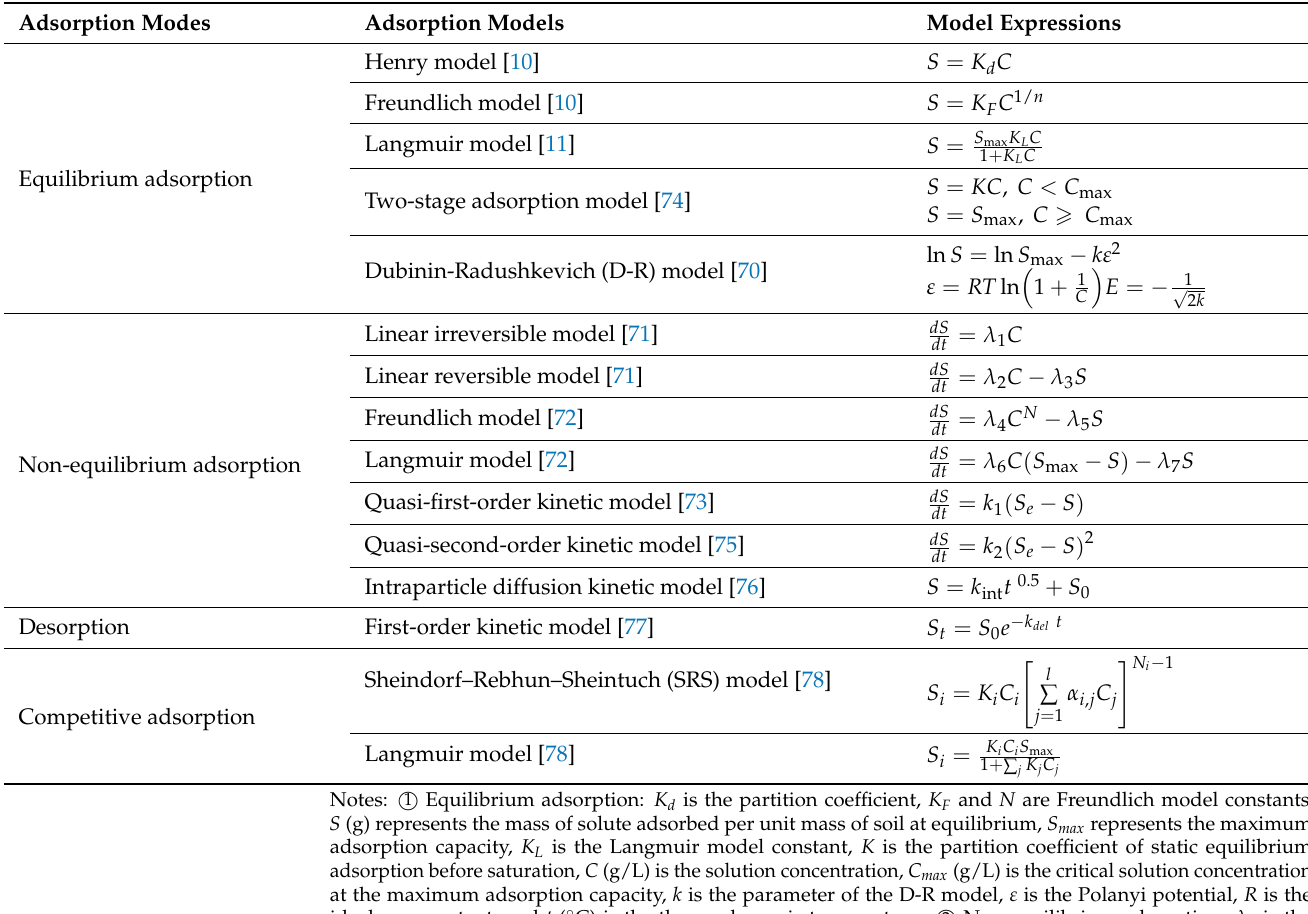
Table 4. Classical adsorption models of various adsorption